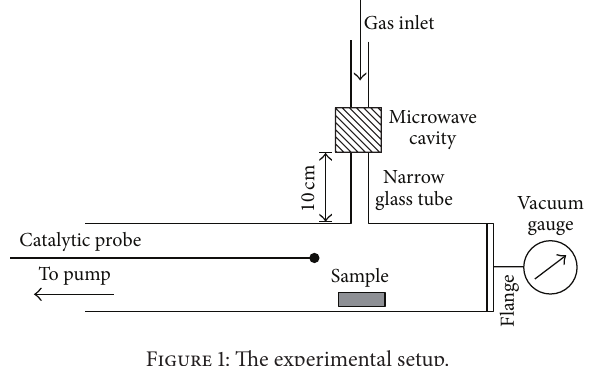
Figure 1: The experimental